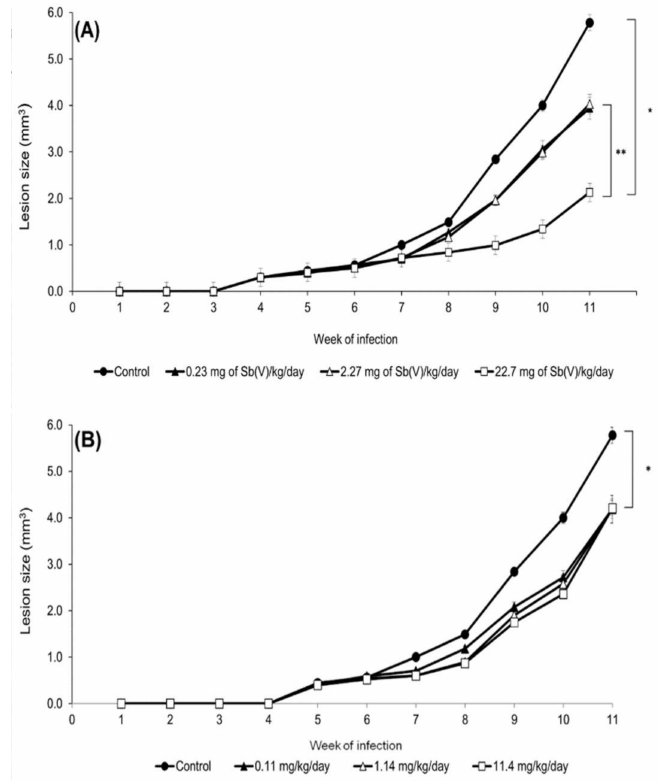
Figure 3. Treatment of experimental infection in BALB/c mice caused by Leishmania ( L. ) amazonensis . Mice were inoculated subcutaneously, in the left footpad, with 1.0 × 10 4 promastigotes at the logarithmic phase of growth. After 4 weeks of infection, mice were treated daily with meglumine antimoniate ( A ) or Epoxymethoxy-lawsone ( B ) at three different concentrations administered subcutaneously in groups with five